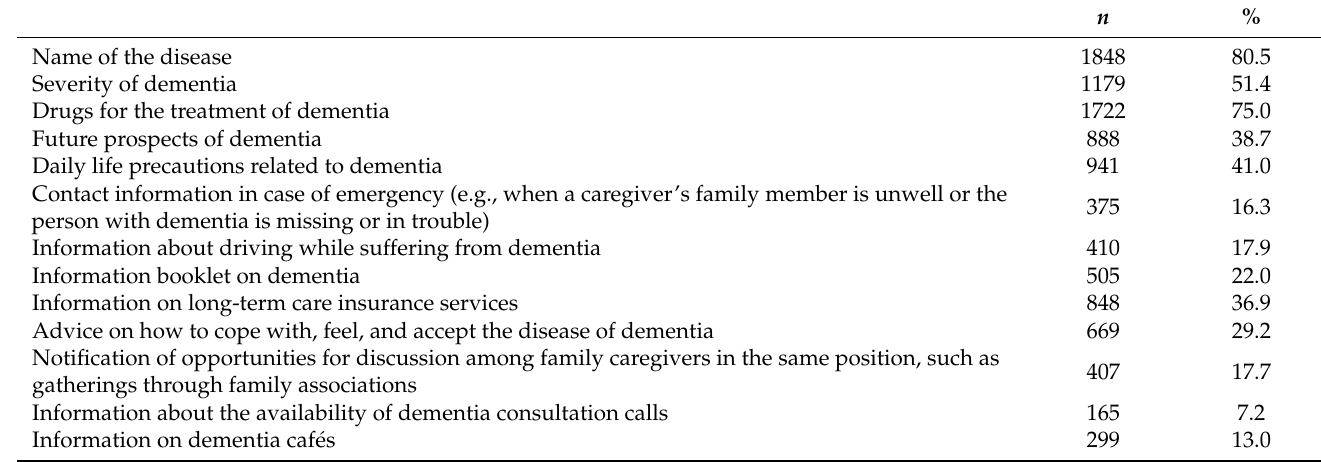
Table 3. Information provided from medical institutions.